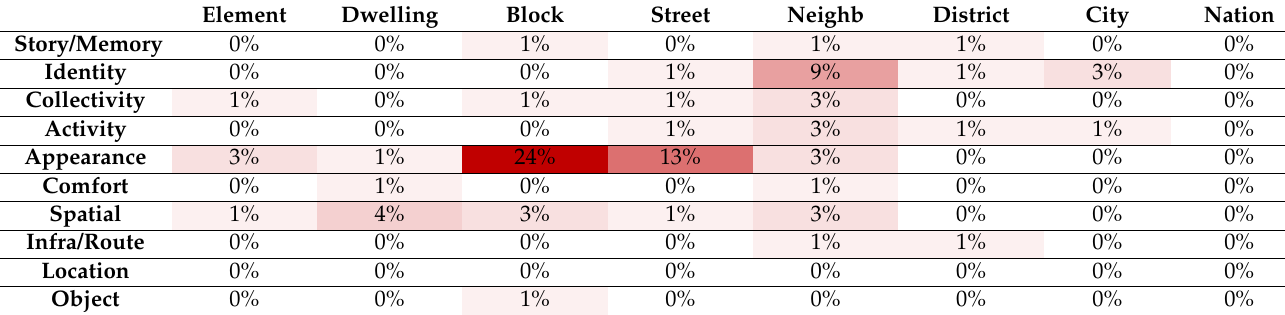
Table A3. Visitors: seven